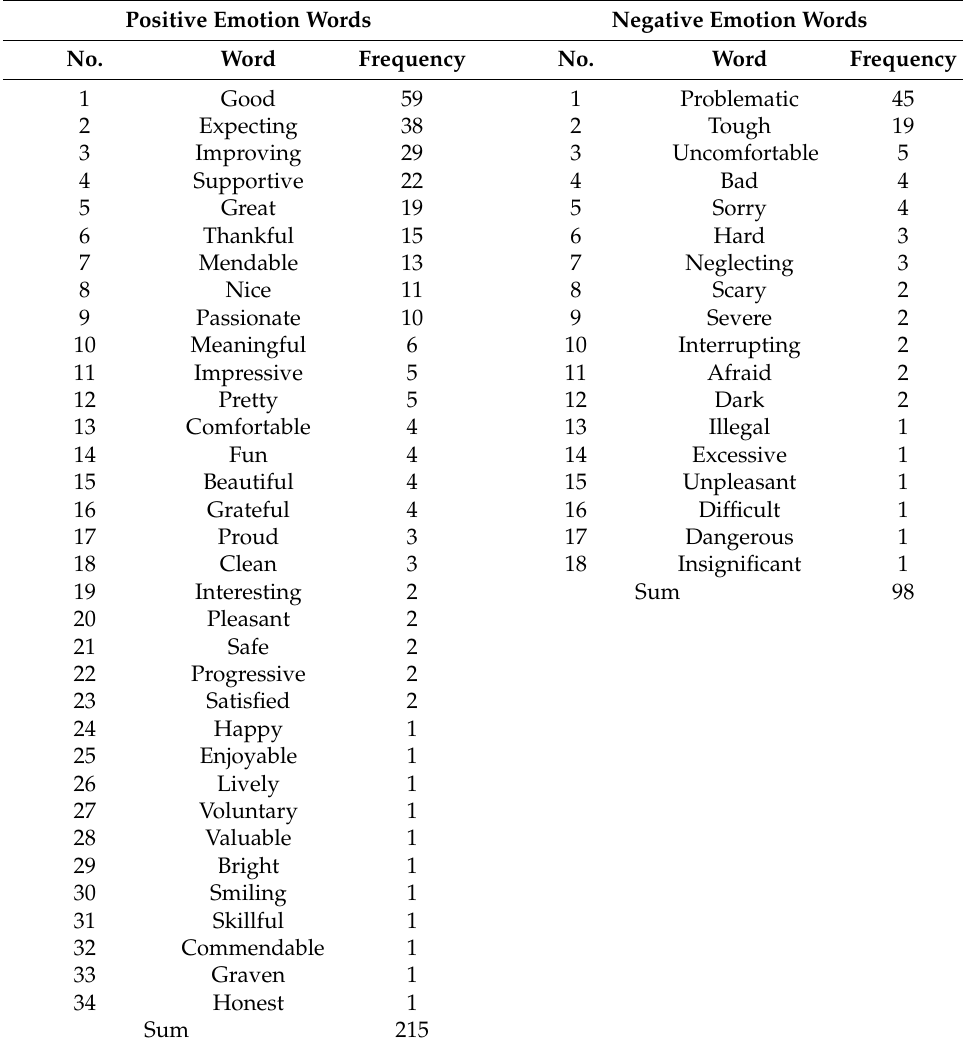
Table 3. Positive and negative emotional analysis of